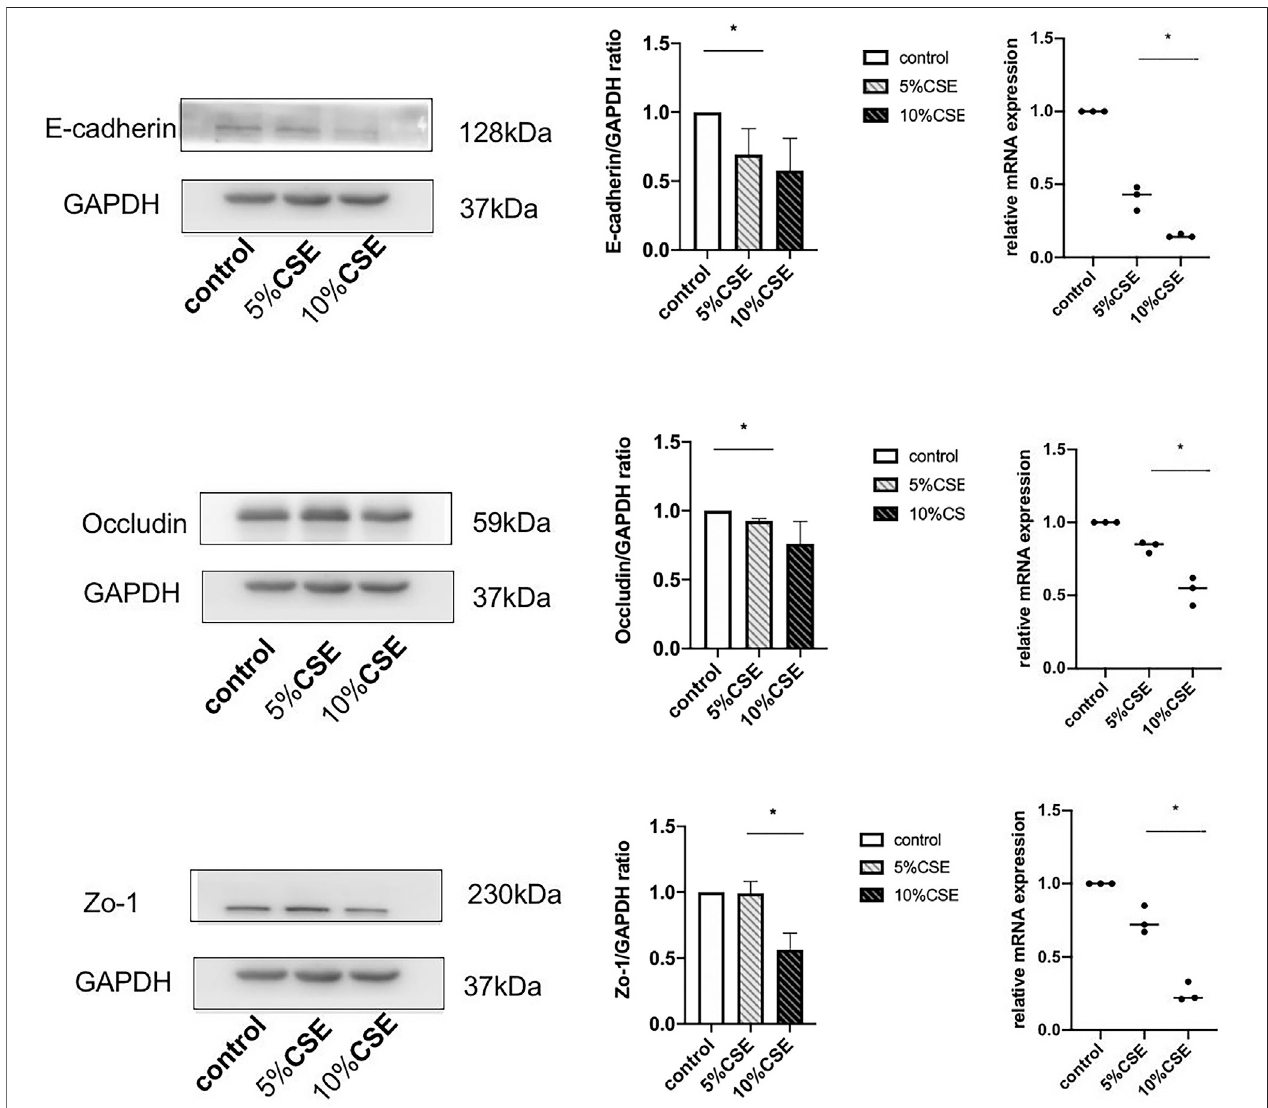
FIGURE 3 | Western blotting and real-time quantitative reverse-transcriptase PCR results showing TJ and AJ protein expression in BEAS-2B cells in the presence orabsenceof5and10%CSEfor24 h.Band intensitywasquantitatedusingdensitometry.Allresultsarerepresentativeofatleastthreeindependentexperiments. Data are shown as the mean ± SD. * p < 0.05 by one-way